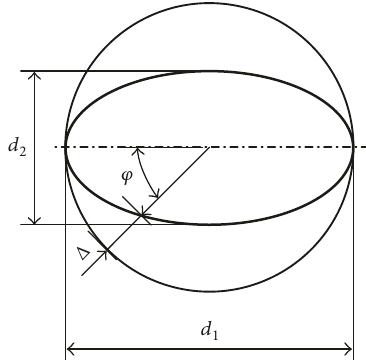
Figure 3: Horizontal profile of piston skirt.